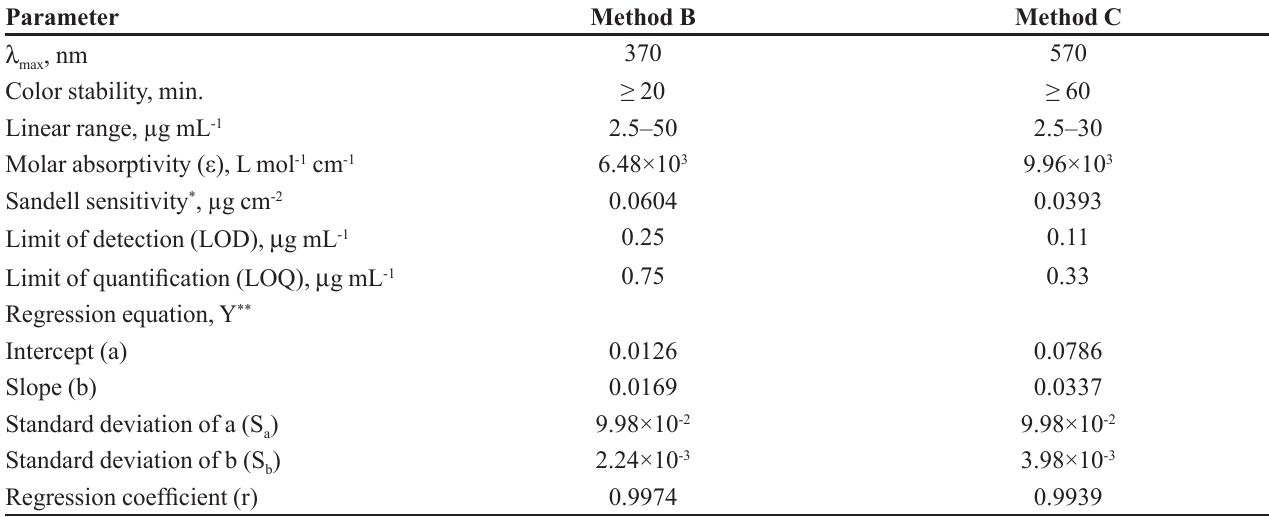
TABLE I - Sensitivity and regression parameters of spectrophotometric methods Parameter